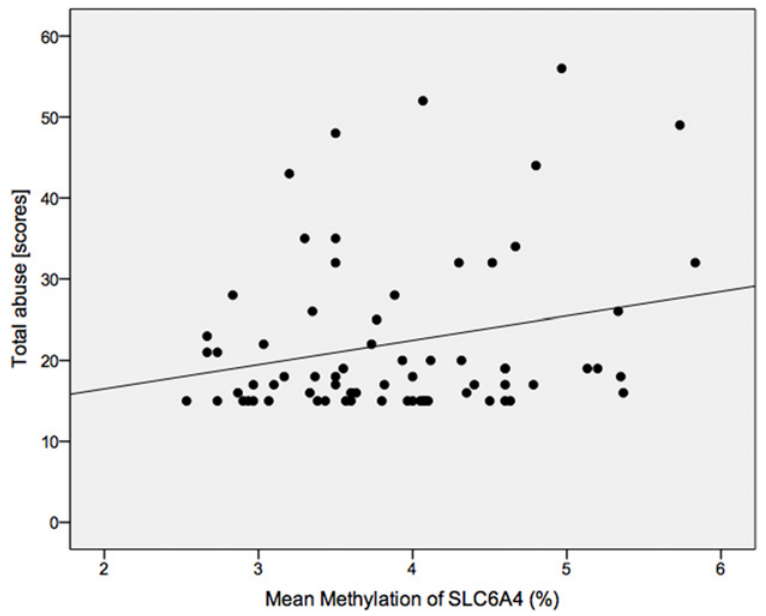
Fig 3. Scatterplot showing the association between total childhood abuse and methylation of SLC6A4 . There was a positive correlation between both variables indicating that more abuse is associated with higher levels of